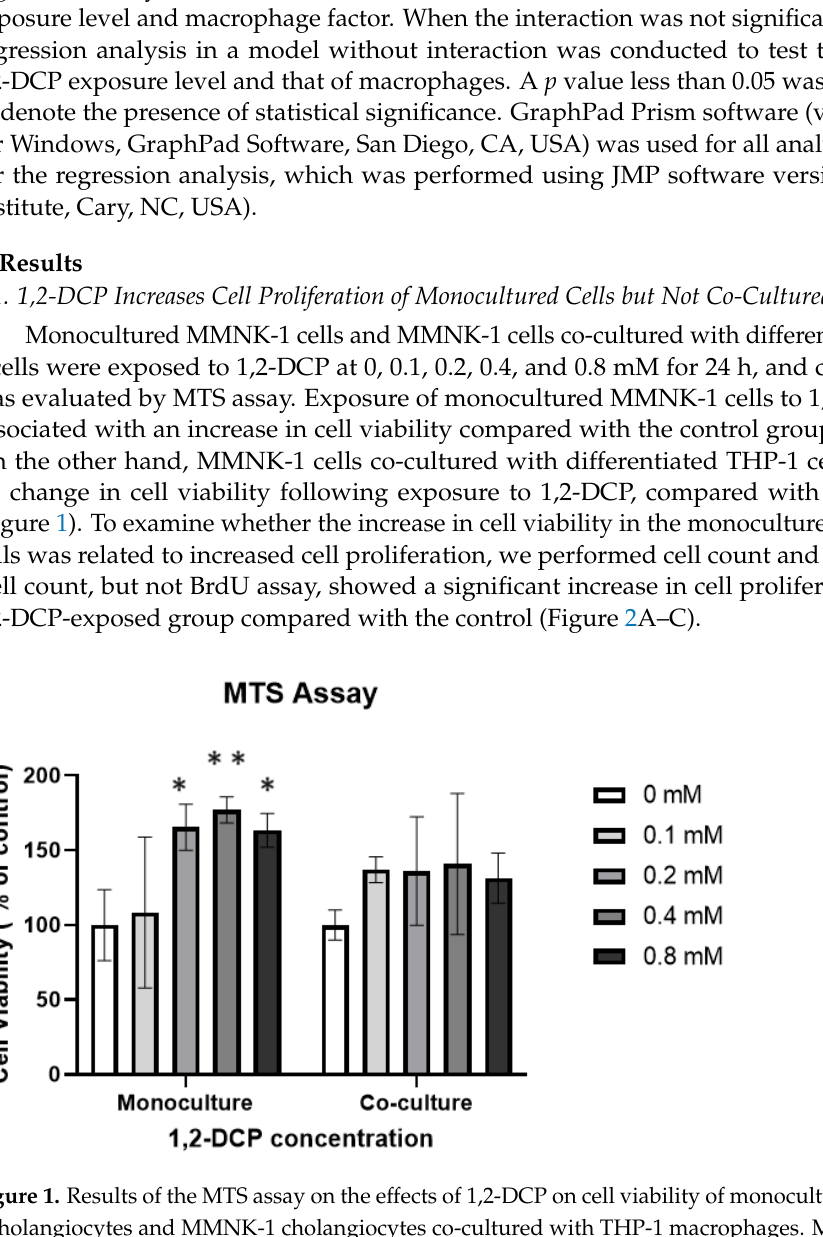
Figure 2. Effects of 1,2-DCP on cell proliferation of monocultured MMNK-1 cholangiocytes. Monocultured MMNK-1 cells were exposed to 1,2-DCP at 0, 0.1, 0.2, 0.4, and 0.8 mM for 24 h. ( A ) Photomicrographs of BrdU immunocytochemistry. MMNK-1 cells were incubated with BrdU labelling medium for 45 min. The cells were washed, fixed with ethanol, blocked with hydrogen peroxide and 1% BSA in PBS, and incubated with anti-BrdU antibody, then with the secondary antibody. The brown color was developed using DAB and nuclei were counterstained with hematoxylin. Cells were observed under a light microscope. Scale bar = 100 µm. ( B ) BrdU labelling index (ratio of the number of BrdU-positive nuclei to the total number of nuclei). ( C ) Cell count (Percentages are in relation to 0 mM 1,2-DCP group). Data are mean ± SD, n = 3. * p < 0.05, ** p < 0.01 compared with the control group (0 mM), by one-way ANOVA followed by Dunnett’s multiple comparison test.